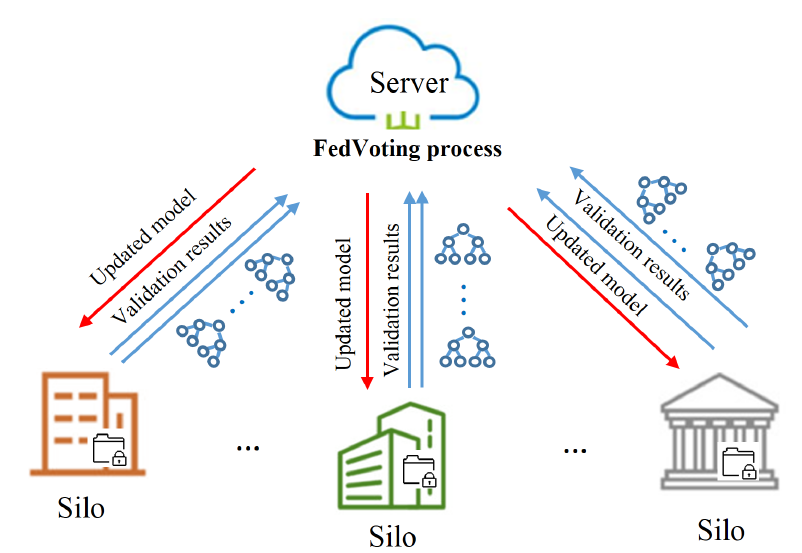
Figure 1. The architecture of the cross-silo federated GBDT